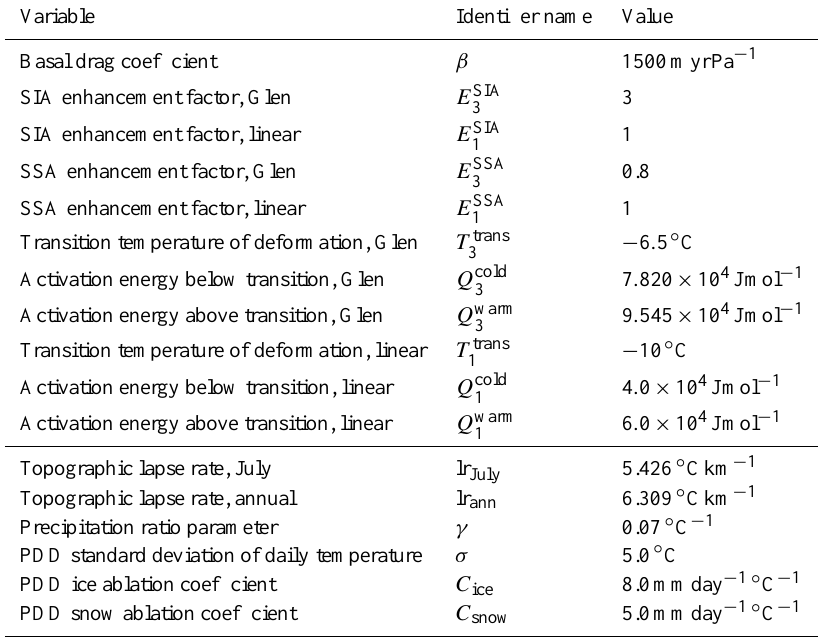
Table 1. Model parameters used in the GRISLI model for this